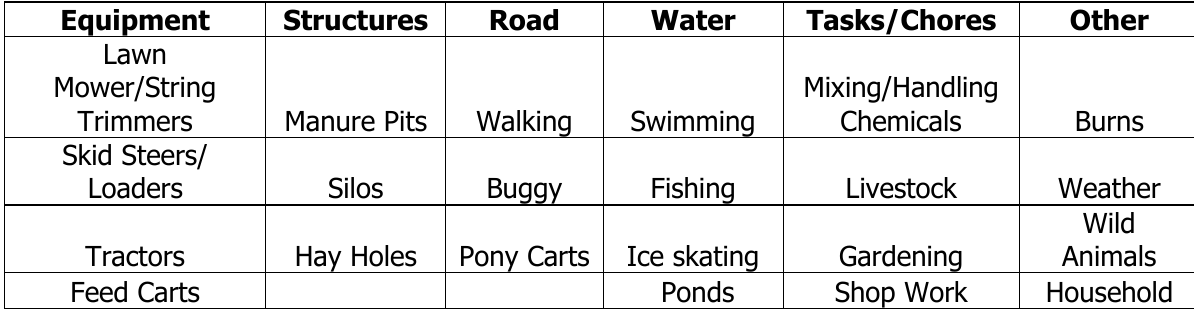
Rural Safety Themes and Associated